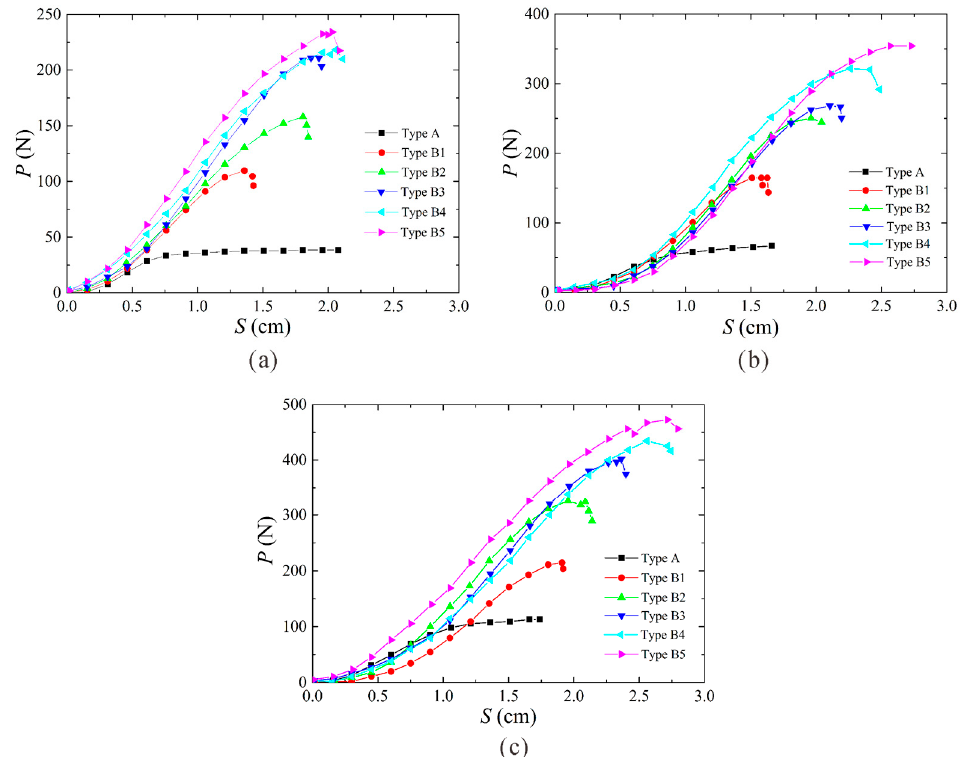
Figure 4. Load–displacement curves of the TAs under vertical pullout loading ( a ) D r = 0.6; ( b ) D r = 0.7; ( c ) D r = 0.8.